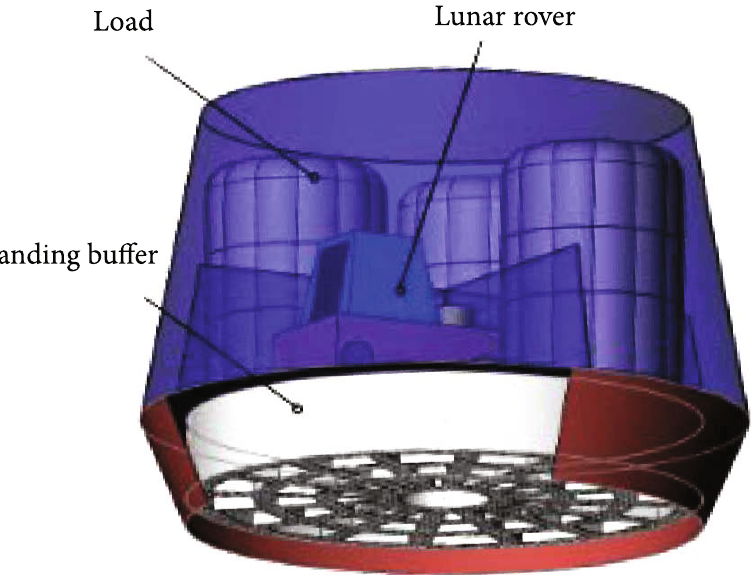
Figure 4: The schematic diagram of the whole lander.